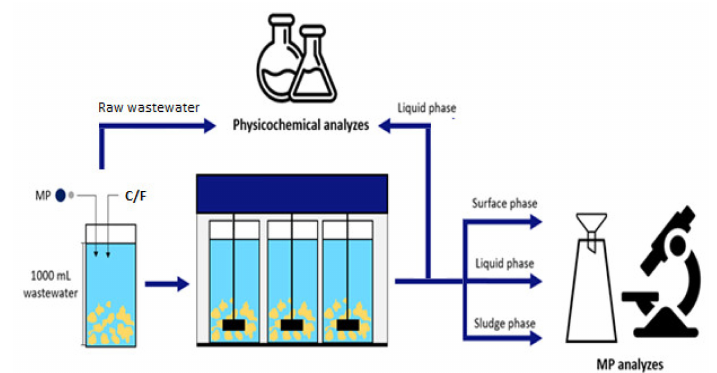
Three fractions were collected from the experimental beakers: surface phase (upper 100 mL of wastewater and floated suspensions), liquid phase, and sludge phase (100 mL of sludge and wastewater from the bottom of the beaker); it was assumed that MP was present in the surface and sludge phase. Each collected fraction was filtered on filters with a pore diameter of 125 µ m in a Büchner funnel at a constant vacuum of 500 g/cm 2 (Figure 1). Each sample was filtered several times to avoid overloading a filter with suspended solids which may obscure the MP count. The readings from all filters were summed to describe the content of MP in a particular sample. Filtration was carried out in a laminar flow box to avoid loss of particles. The MP particles on the filters were counted using an optical binocular (Delta Optical SZ-450) with a 10 × zoom in the darkroom, using UV to activate the fluorescent dye.